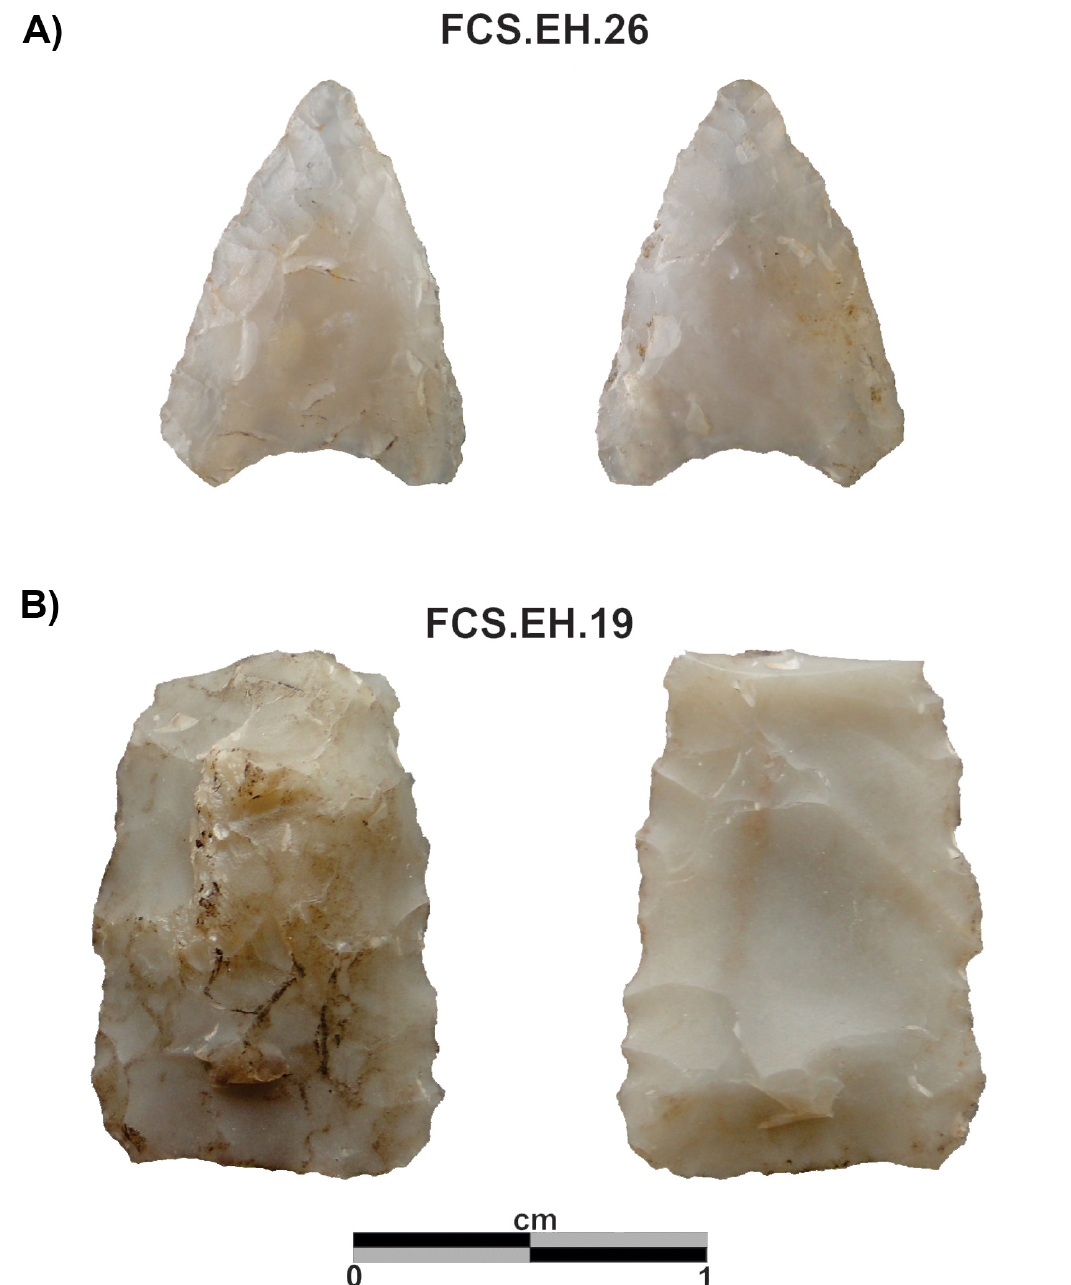
Figure 2. Arrows manufactured on